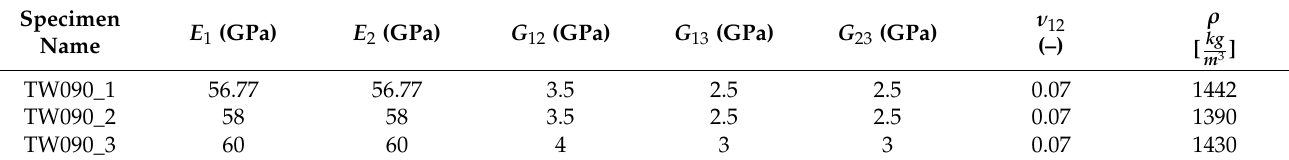
Table 1. Mechanical properties of CFRP composite used for samples in the research.